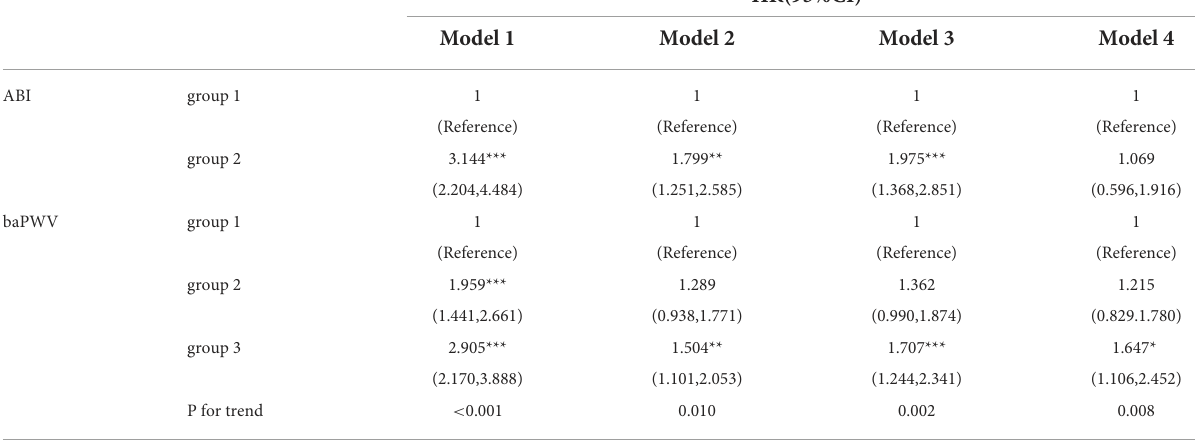
TABLE 3 Cox regression analysis of the relationship between ABI, baPWV, and all-cause